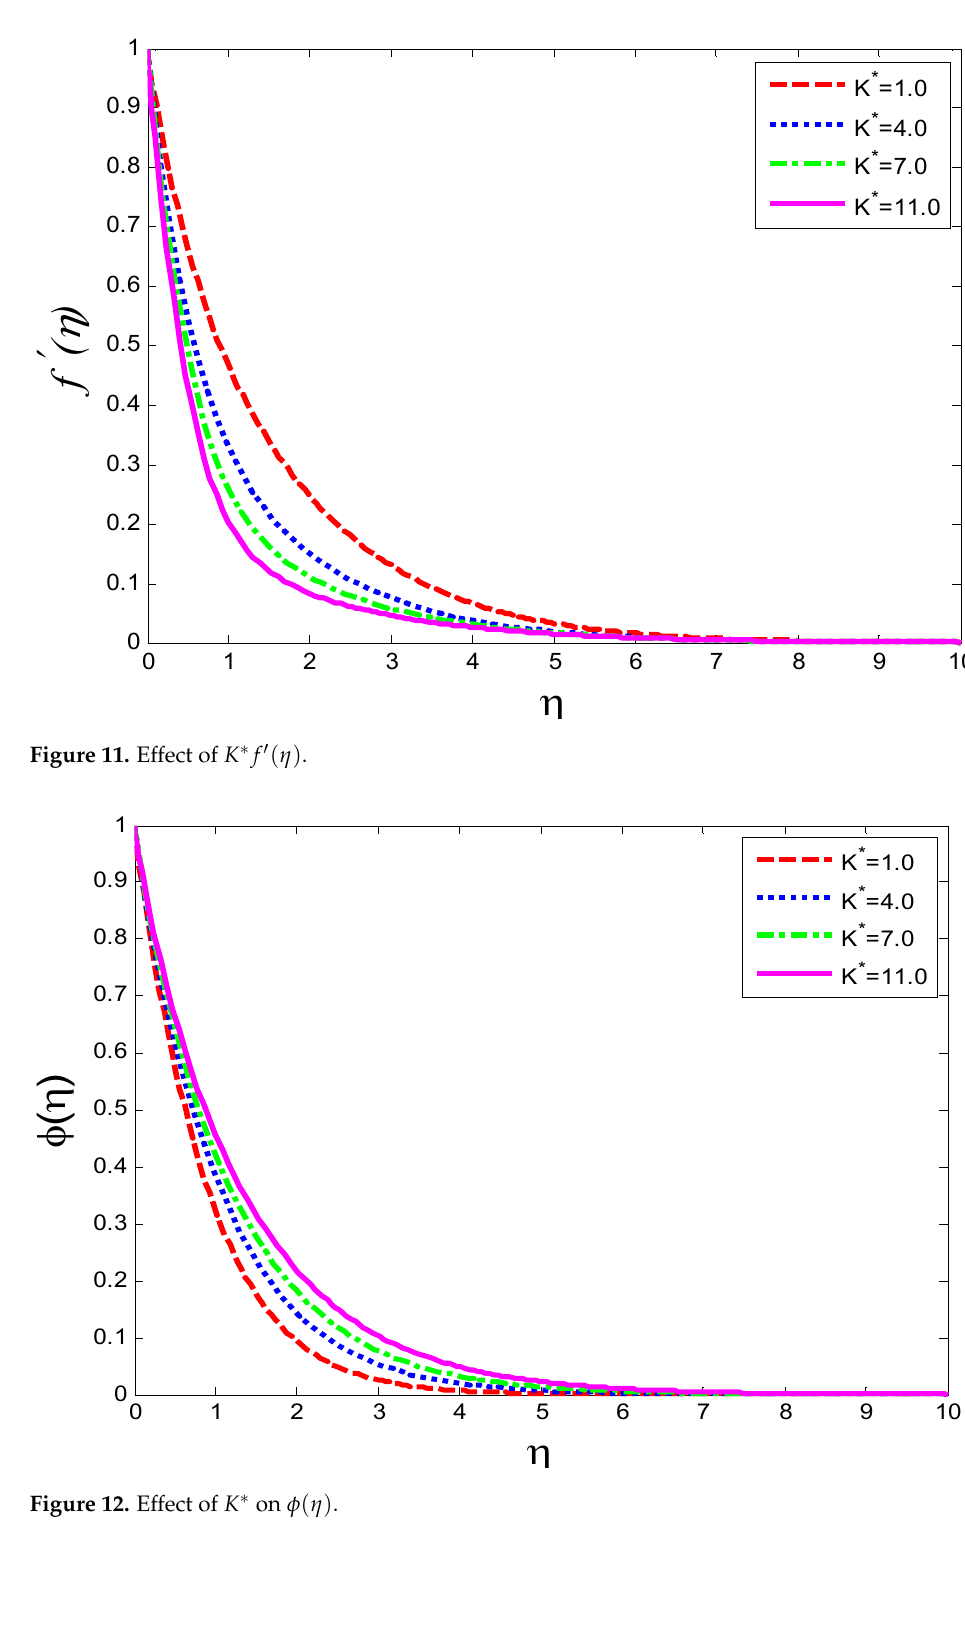
Figure 10. Effect of 𝛼 on 𝑓 (cid:4593) (cid:4666)𝜂(cid:4667) .